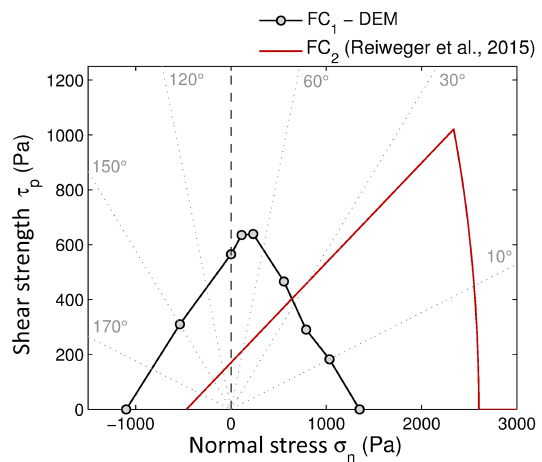
Figure 3. Failure criterion FC 1 of our modeled weak layer (black circles) obtained from mixed-mode shear-compression loading tests. FC 2 is the high-rate mixed-mode failure envelope found by Reiweger et al. (2015). The grey dotted lines represent angles of loading ψ such as tan ψ = τ g /σ n where τ g is the shear stress. Com- pression corresponds to positive values of σ n